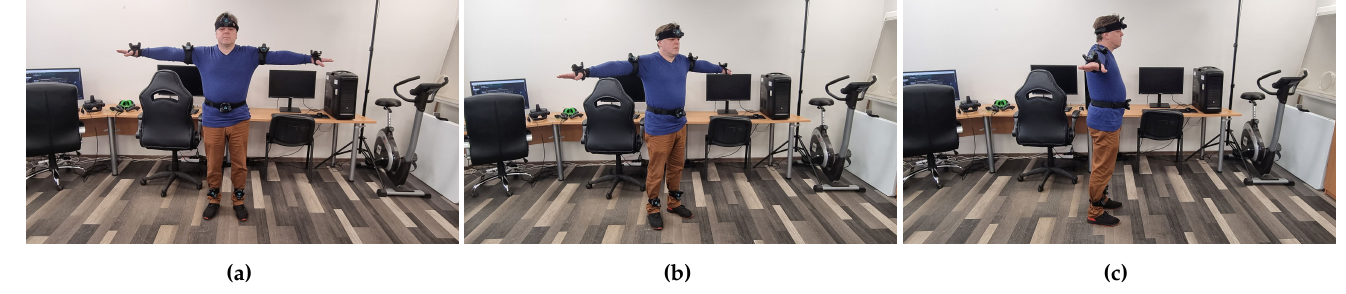
Figure 5. Example of sensor mounting: ( a ) front view, ( b ) 45-degree view, and ( c ) side